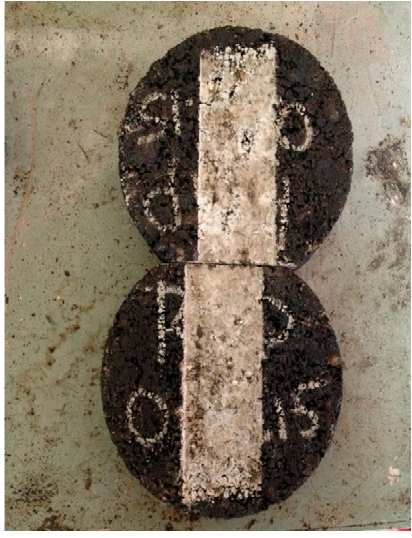
Figure 6. Saw-cut specimens for HWTD.